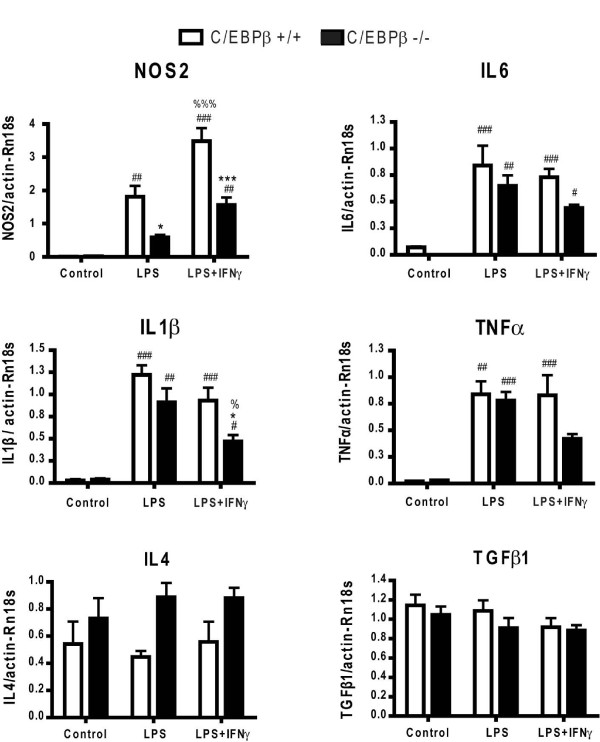
Reduced proinflammatory gene expression in C/EBPβ-/- mixed glial cultures. Expression of pro-inflammatory (NOS2, IL-1β, IL-6 and TNFα) and anti-inflammatory (IL-4 and TGFβ1) genes in C/EBPβ+/+ (white bars) and C/EBPβ-/- (black bars) mixed glial cultures. Cultures were treated with LPS or LPS+IFNγ for 6 h and then mRNA levels were analyzed by qPCR. In wild type cultures LPS and LPS+IFNγ induce expression of the four pro-inflammatory genes studied but do not affect mRNA levels of the anti-inflammatory genes IL-4 and TGFβ1. Absence of C/EBPβ results in significant decreases in LPS-induced expression of NOS2 and in LPS+IFNγ-induced expression of NOS2 and IL-1β. Results are expressed as relative fold units of ΔΔCt value between gene of interest and actin + Rn18s as reference genes. Two-way ANOVA, followed by Bonferroni's test was applied. *p < 0.05, ***p < 0.001 compared to respective C/EBPβ+/+ condition. #p < 0.05; ##p < 0.01; ###p < 0.001 compared to respective control. %p < 0.05; %%%p < 0.001 compared to respective LPS condition.